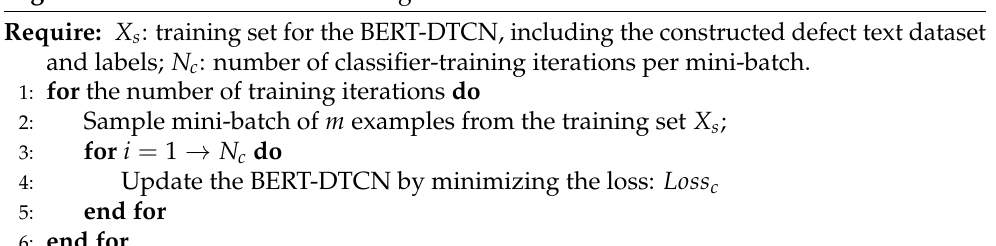
Algorithm 1 Pseudocode for training the